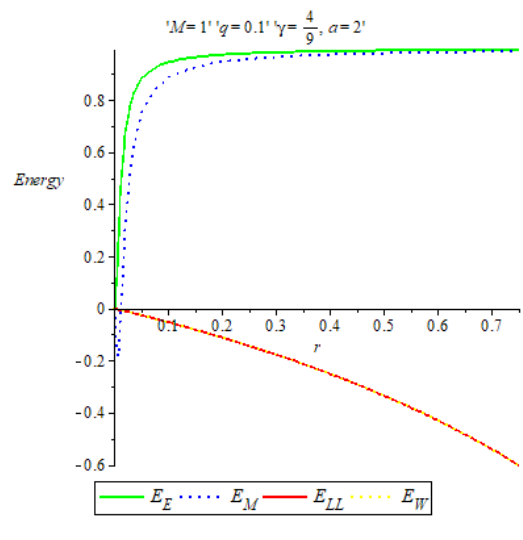
Figure 9. Comparison of energy in the Einstein, Landau-Lifshitz, Weinberg, and Møller prescriptions versus the radial distance r